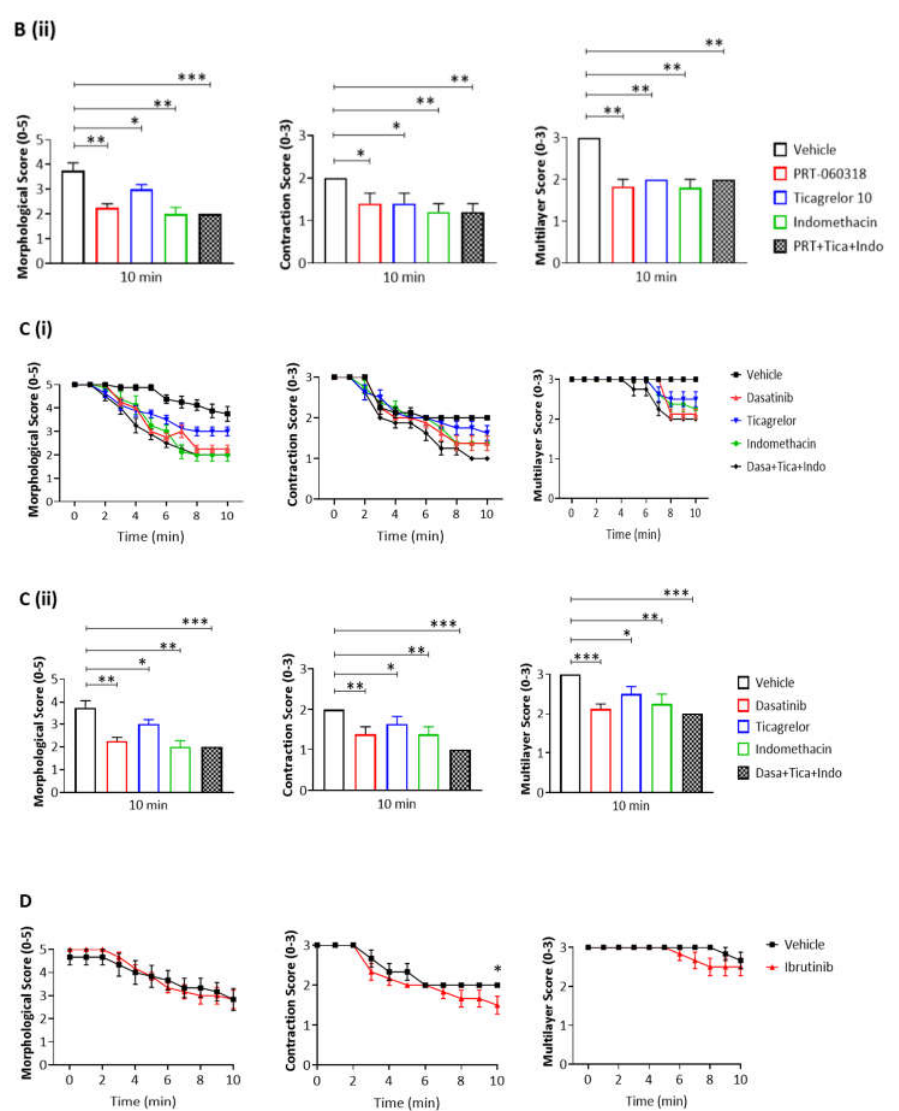
Figure 4. Inhibition of Syk causes the same extent of disaggregation observed with antagonists of adenosine diphosphate (ADP) and thromboxane A 2 (TxA 2 ). Recalcified blood was perfused for 7 min on Horm collagen at 37 °C at arterial shear (1000 s −1 ), and post-perfused for 10 min with rinse buffer with vehicle (DMSO) or inhibitor of Syk, Src or Btk (PRT-060318 10 µM, dasatinib 10 µM or ibrutinib 7 µM, respectively). ( A ) Representative images of aggregates at 0, 5, and 10 min of post-perfusion with vehicle, PRT-060318 ( n = 5) or dasatinib ( n = 6). ( B, C, D ) Graphs showing extent of disaggregation, as measured from scores of thrombus morphology, contraction and multilayer, 16 at every 60 s ( Bi-Ci-D ) or at 10 min ( Bii-Cii ) of post-perfusion with either vehicle, PRT-060318 (PRT) ( Bi–ii ), dasatinib ( Ci–ii ) or ibrutinib ( D ), alone or combined with indomethacin (Indo, 10 µM) and ticagrelor (Tica, 10 µM). Scale bar = 50 µm. Data are shown as mean + s.e.m. * p < 0.05, ** p < 0.005, *** p < 0.0005, one-tailed paired Student’s t -test.